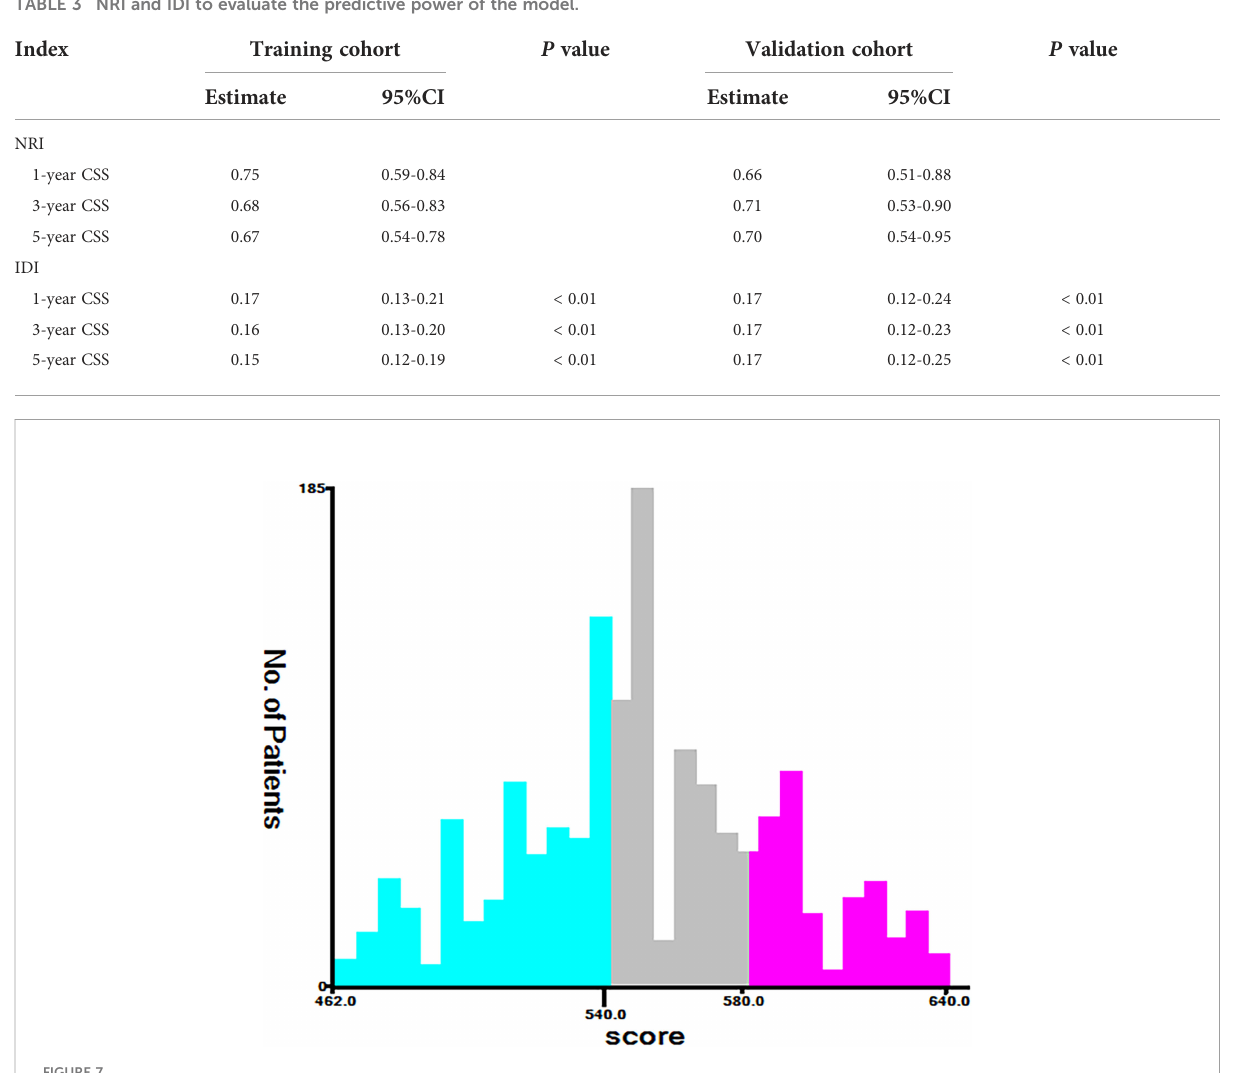
FIGURE 7 The basis for grouping new risk strati fi cation (Cut-off point selected using